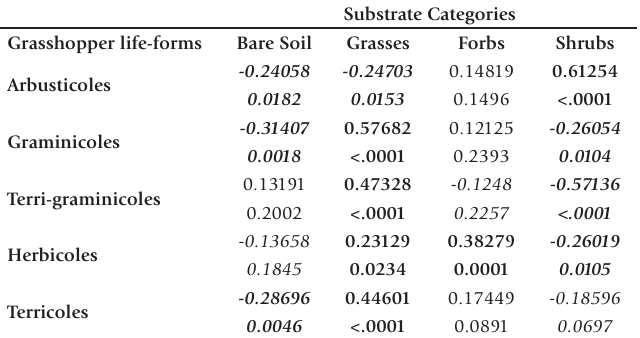
) and signifi- Table 4. Spearman-rank correlation coefficients (r S cance values (P) from testing relationships between grasshopper life-forms and the available cover of substrate categories measured on the grasshopper and vegetation transects at each study site, over all years and seasons. Correlation coefficients are listed first, above significance values within each life-form by substrate set of cells. Significant (P<0.05) correlations are in bold text, positive correla- tions are in regular font and negative correlations are in italic